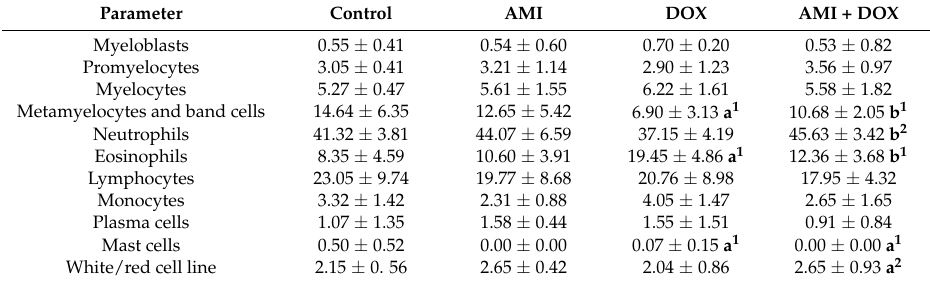
Table 2. The influence of different treatment on myelogram (%) in the bone marrow 28 days after receiving last treatment.